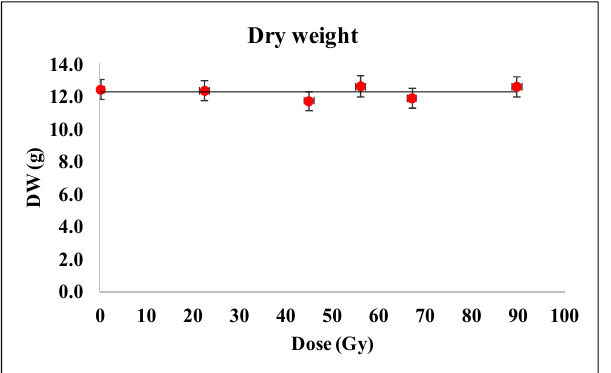
Figure 1. Dry weight (DW) in the wheat seedlings grown from the proton beam irradiated seeds. Twenty seedlings for each experimental variant were measured.